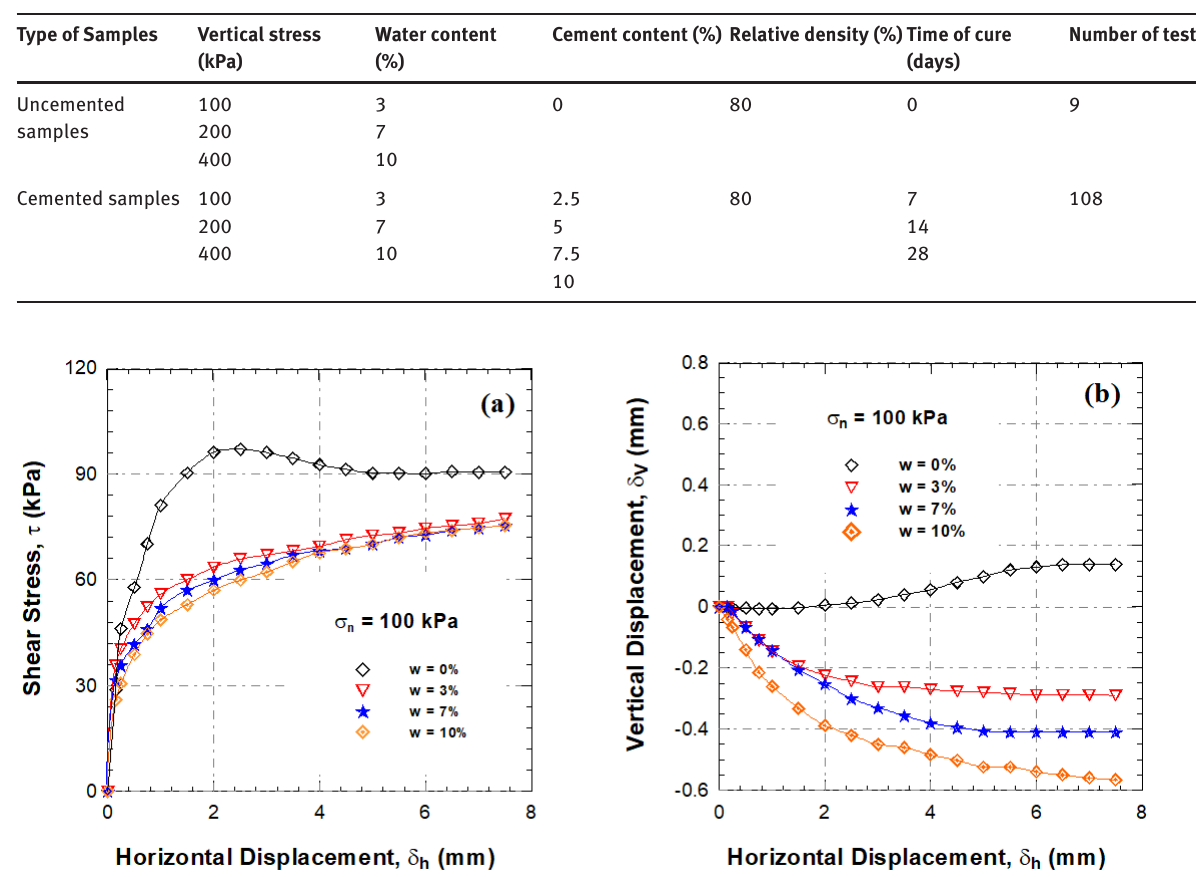
Table 3: Parameters of the experimental program.